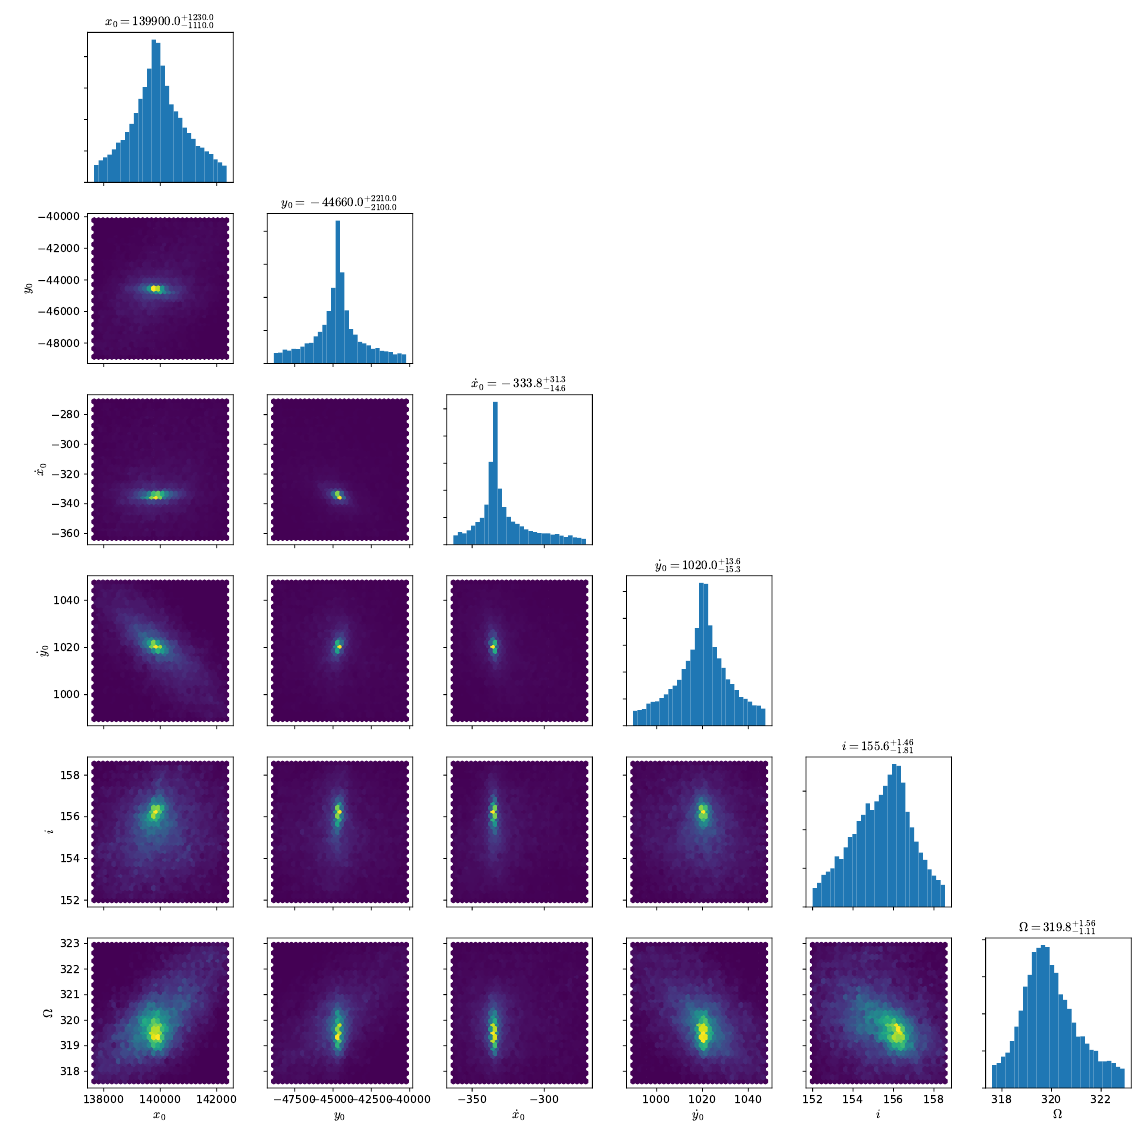
Figure A3. The posterior distribution of the orbital parameters of the S55 star. The units are the same as in Figure